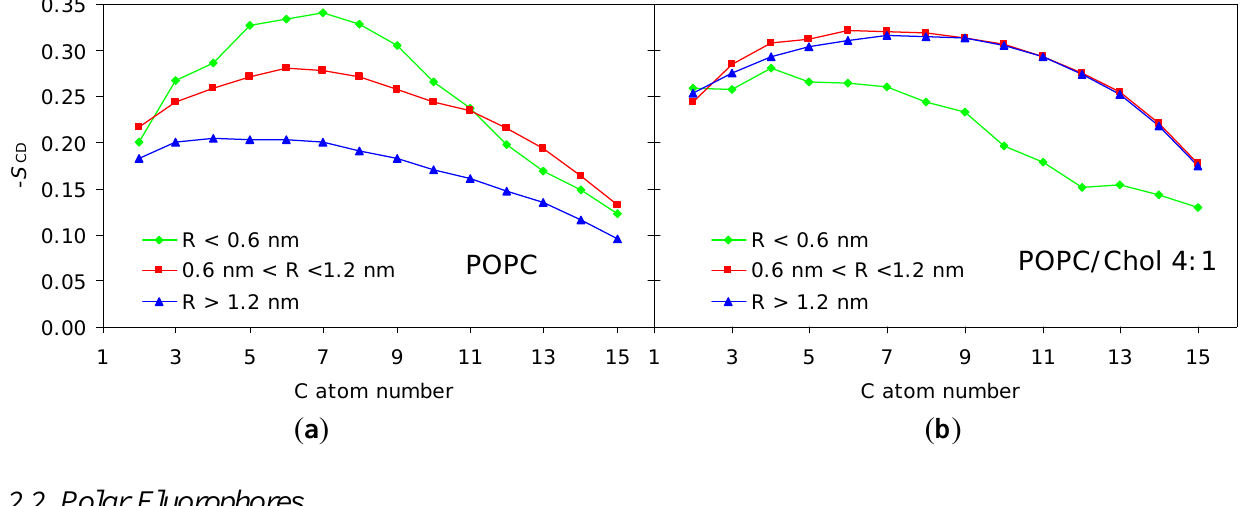
Figure 2. Deuterium order parameter profile of the POPC sn -1 chain for varying proximity to the closest pyrene molecule ( R ) in the 100-ns MD simulation of ( a ) POPC/pyrene (128:2) and ( b ) POPC/cholesterol/pyrene (120:30:2) bilayers. For R > 1.2 nm, the profiles are essentially identical to those obtained in absence of probe in both systems (not shown). Significant local ordering is observed for R < 1.2 nm in ( a ), whereas significant local disordering is observed for R < 0.6 nm in ( b